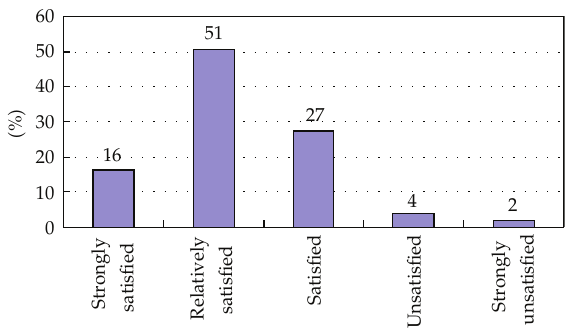
Figure 8: Satisfaction for travel